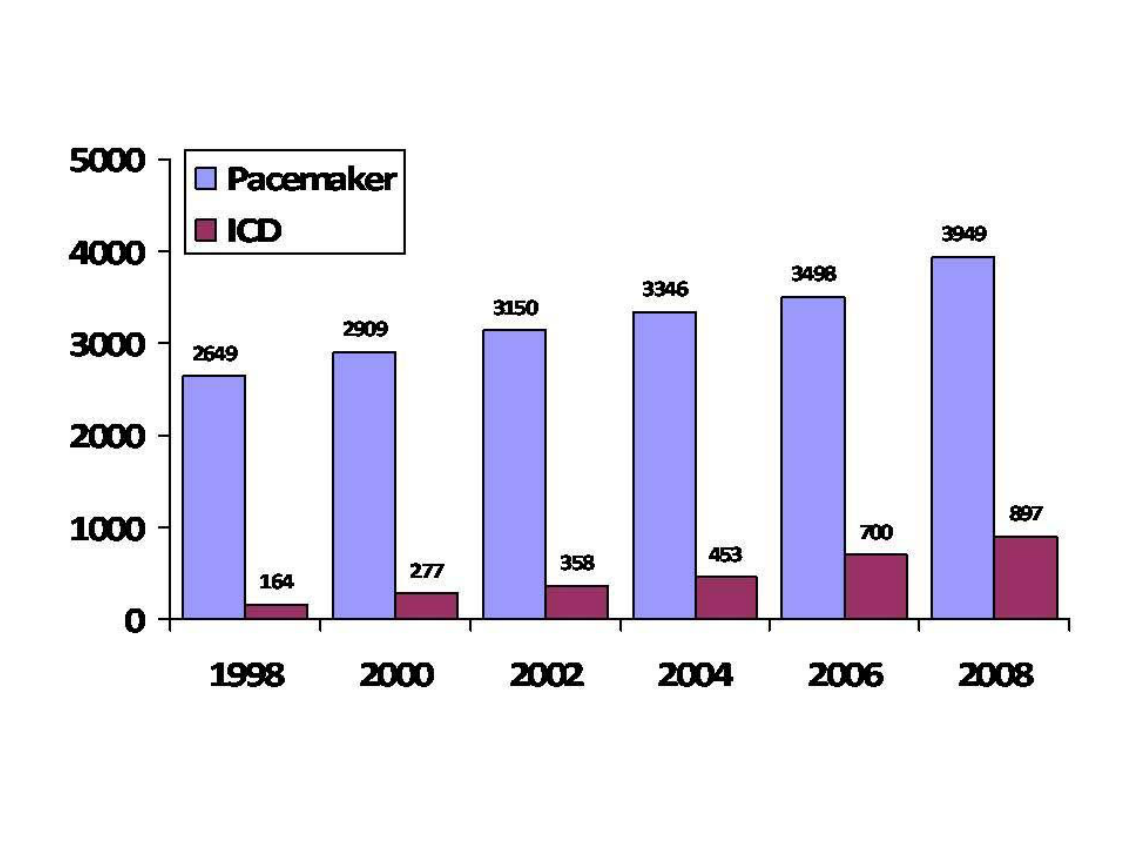
Yearly first pacemaker and ICD implants in Switzerland 1992–2008. From